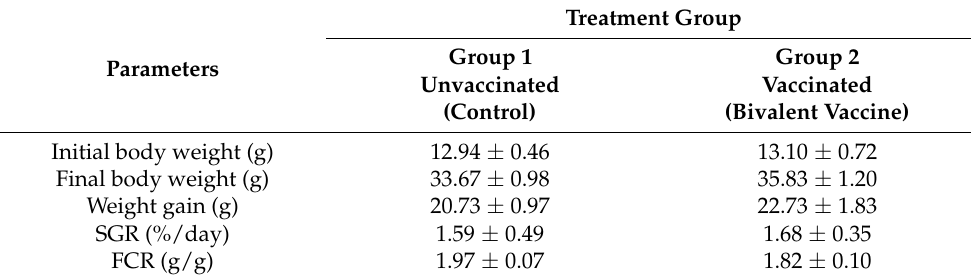
Table 2. Effects of the dietary inclusion of different treatments on red hybrid tilapia’s final weight, weight gain, specific growth rate (SGR), and feed conversion ratio (FCR). Values are the mean ± standard deviation in triplicate samples. Insignificant differences ( p ≥ 0.05) between control and vaccinated